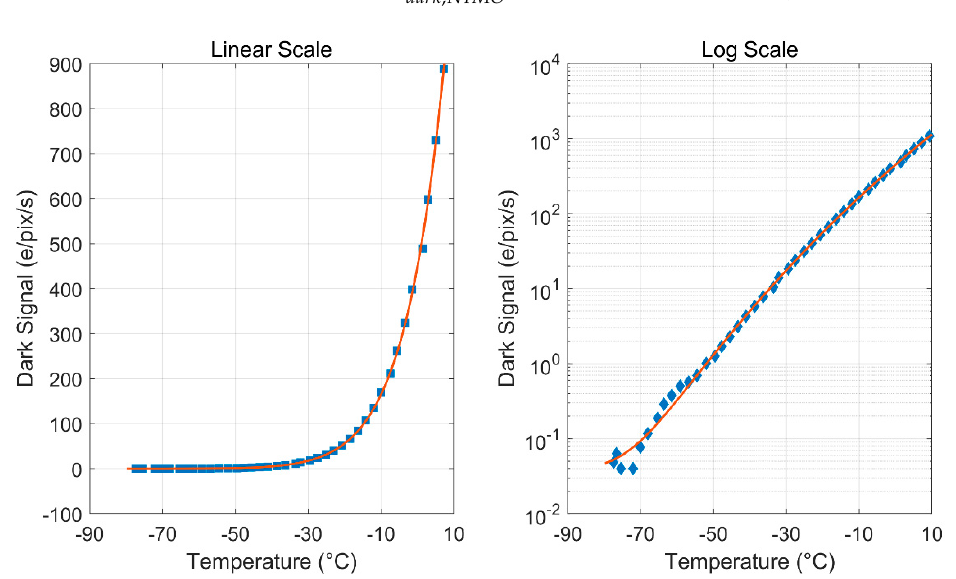
Figure 6. Dark signals as a function of temperature of red channel NIMO CCD. The whole test and fitting results of dark signals as a function of temperature for blue channel AIMO CCD are shown in Figure 7. The results show that the measured data and fitting equation can match well with the determination coefficient R-squared = 0.9963, and the fitting equation in the unit of electrons converted by the gain of 1.45e/DN is shown in Equation